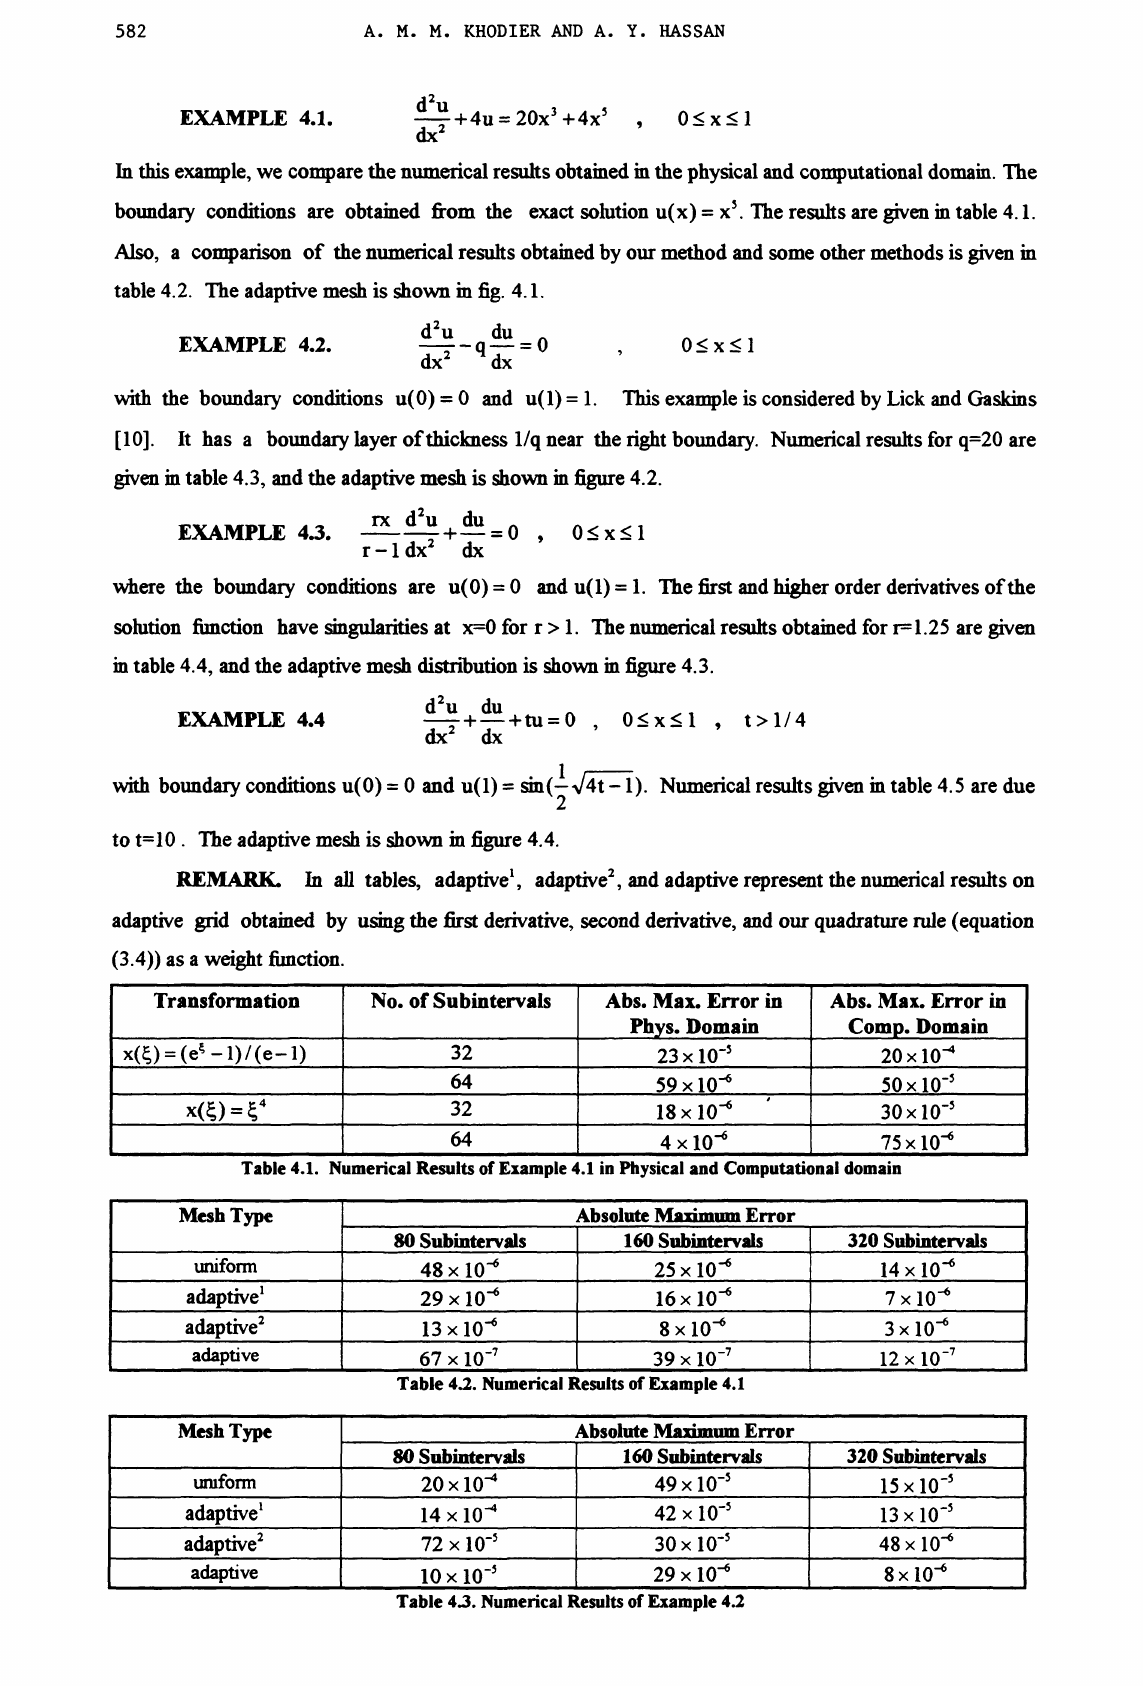
Table 4.2. Numerical Results of Example 4.1